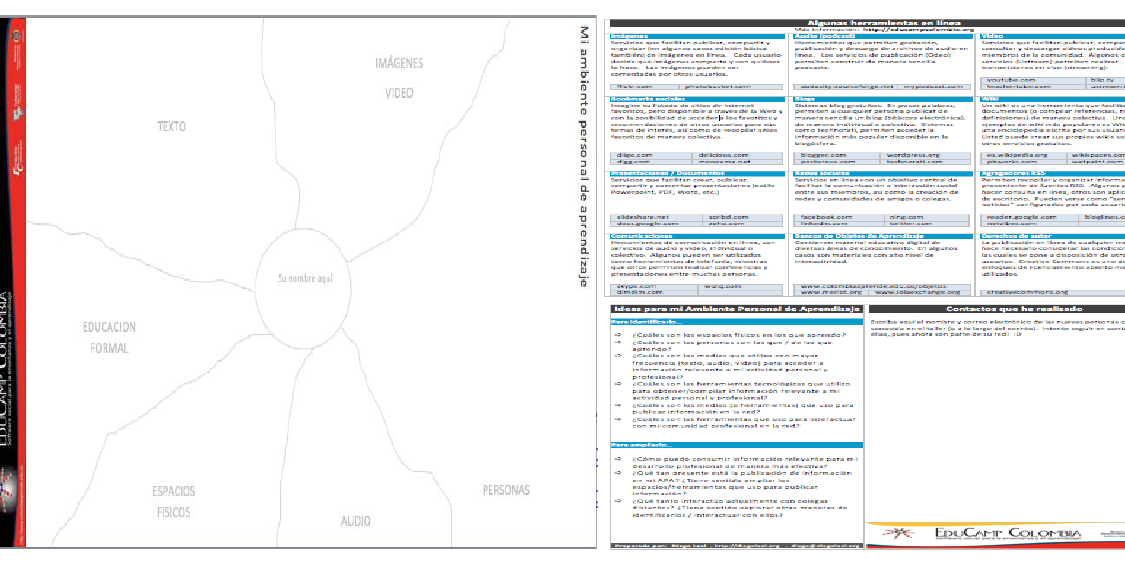
Figure 1 . Facsimile of the PLE outline and the tool sheet ( Available in Spanish